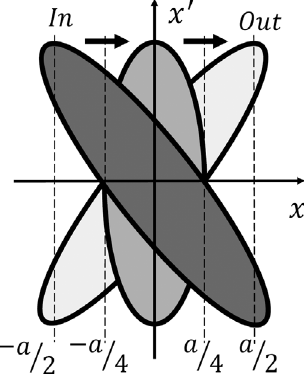
FIG. 13. Transverse ellipse transformation along one KONUS drift tube